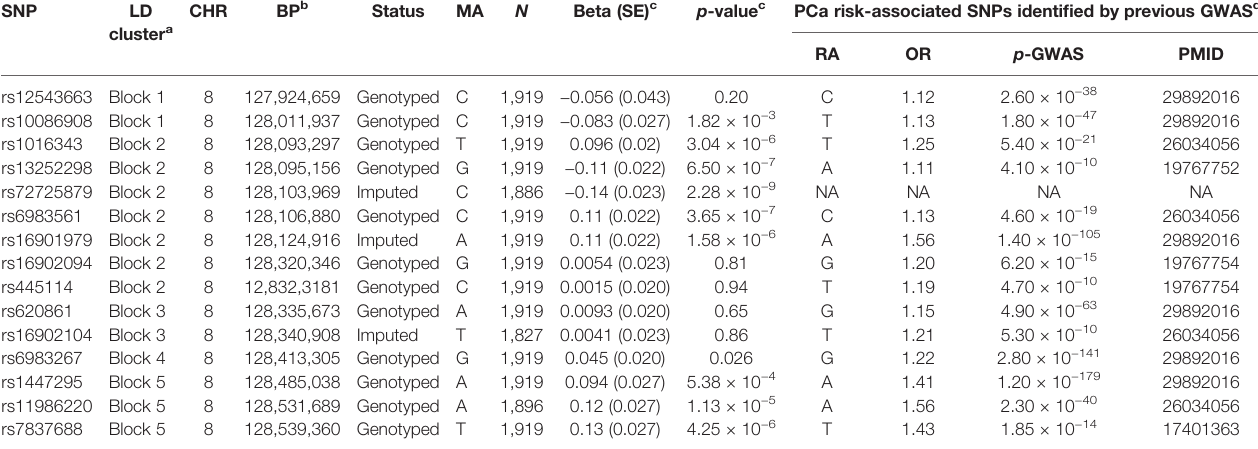
TABLE 3 | Association analysis between logp2PSA and prostate cancer (PCa) risk-associated variants reported by previous genome-wide association study (GWAS) within the region 8q24.21. CHR BP b Beta (SE) c SNP LD cluster a